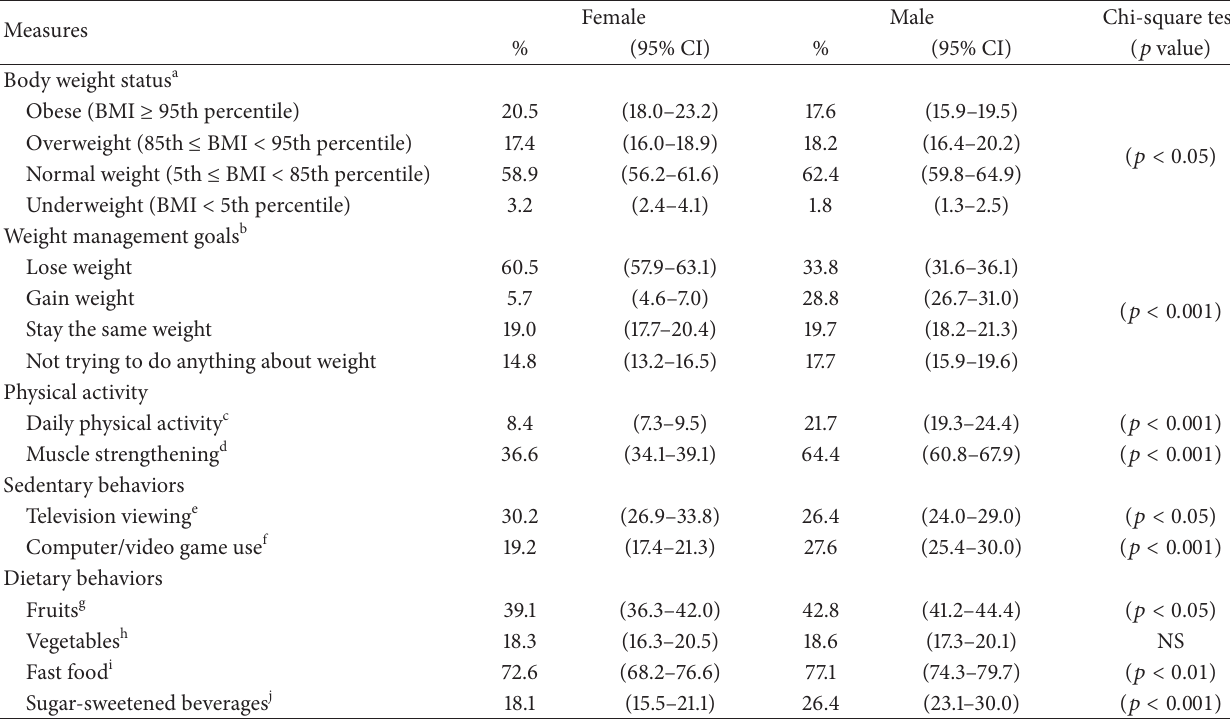
Table 2: Prevalence (%) of body weight status, weight management goals, physical activity, sedentary behaviors, and dietary behaviors by sex, among US high school